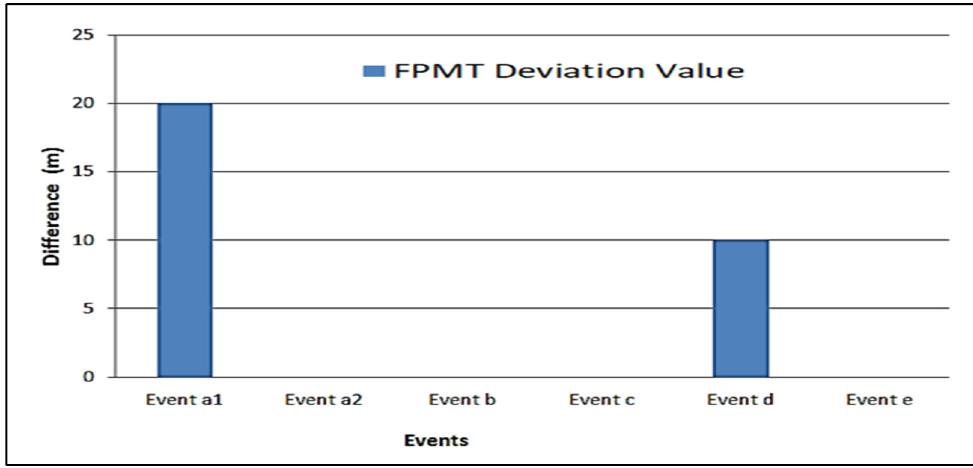
Figure 16. Difference measurement between Actual and FPMT.